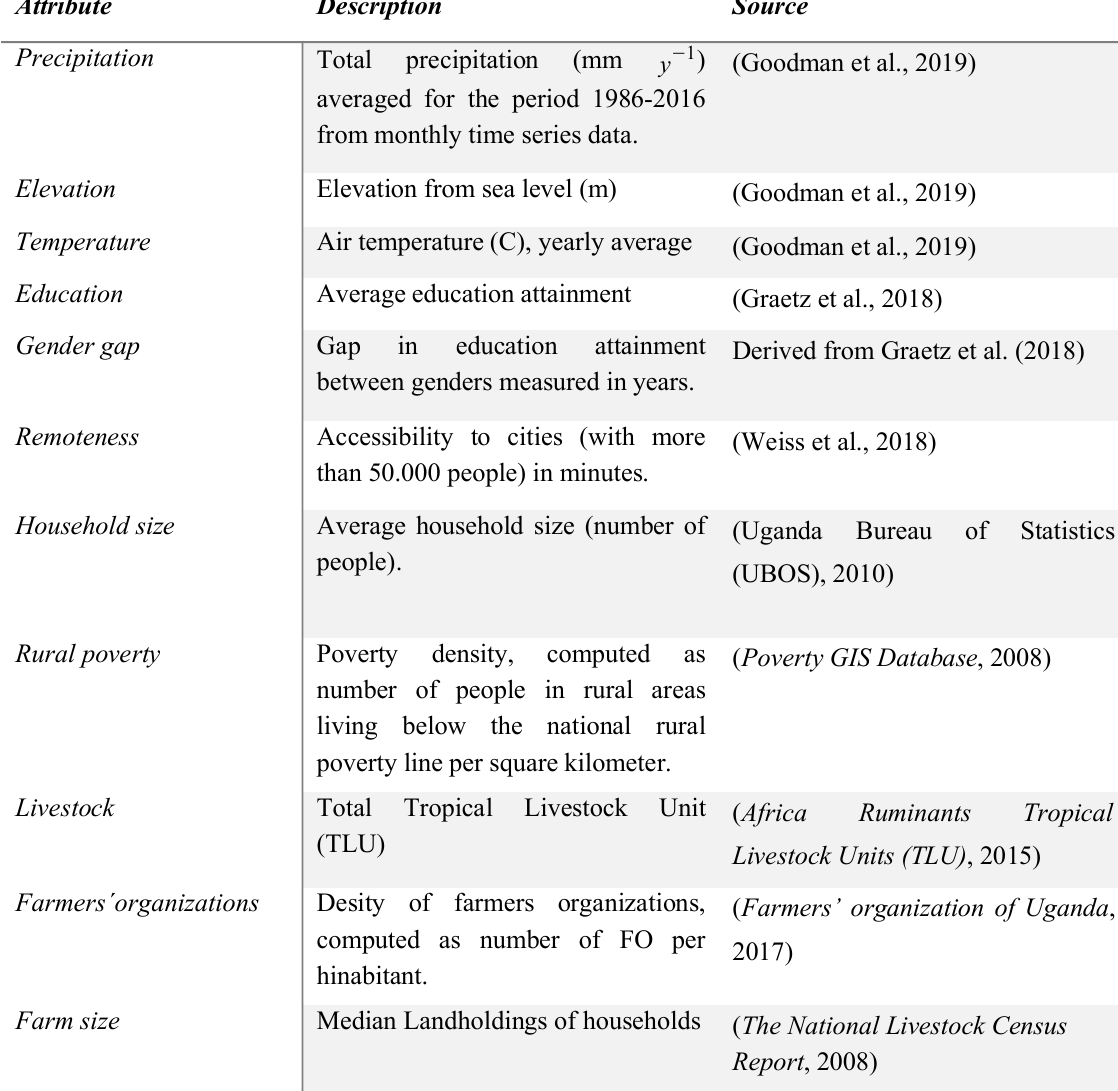
Table A1.2 . Spatial attributes and corresponding datasets used for the classification of spatial archetypes of social-ecological barriers in